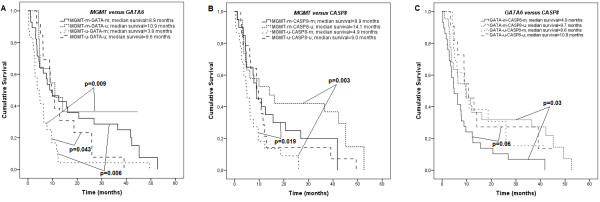
Kaplan-Meier cumulative survival (months) in glioblastoma patients plotted according to concomitant gene methylation patterns. (A) MGMT and GATA6 gene methylation status (log-rank test, χ2 = 13.058, df = 3, P = 0.005), (B) MGMT and CASP8 gene methylation status (log-rank test, χ2 = 12.314, df = 3, P = 0.006), (C) GATA6 and CASP8 gene methylation status (log-rank test, χ2 = 7.712, df = 3, P = 0.052).